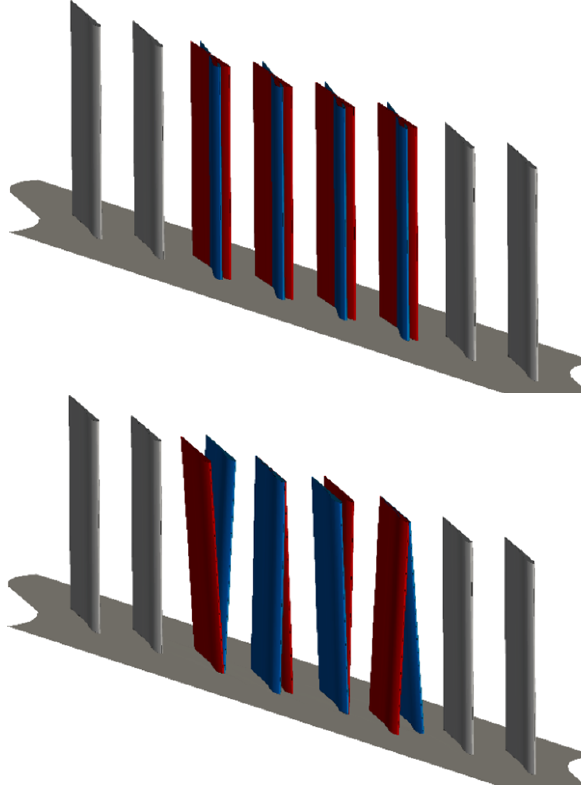
Figure 12. Torsion mode-shape and CFD domain de- formation (up), bending mode-shape and CFD domain deformation (down).